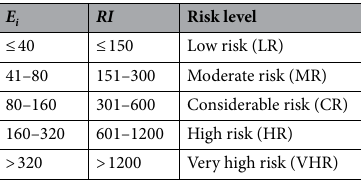
Table 2. Method of ecological risk assessment for fly ash.